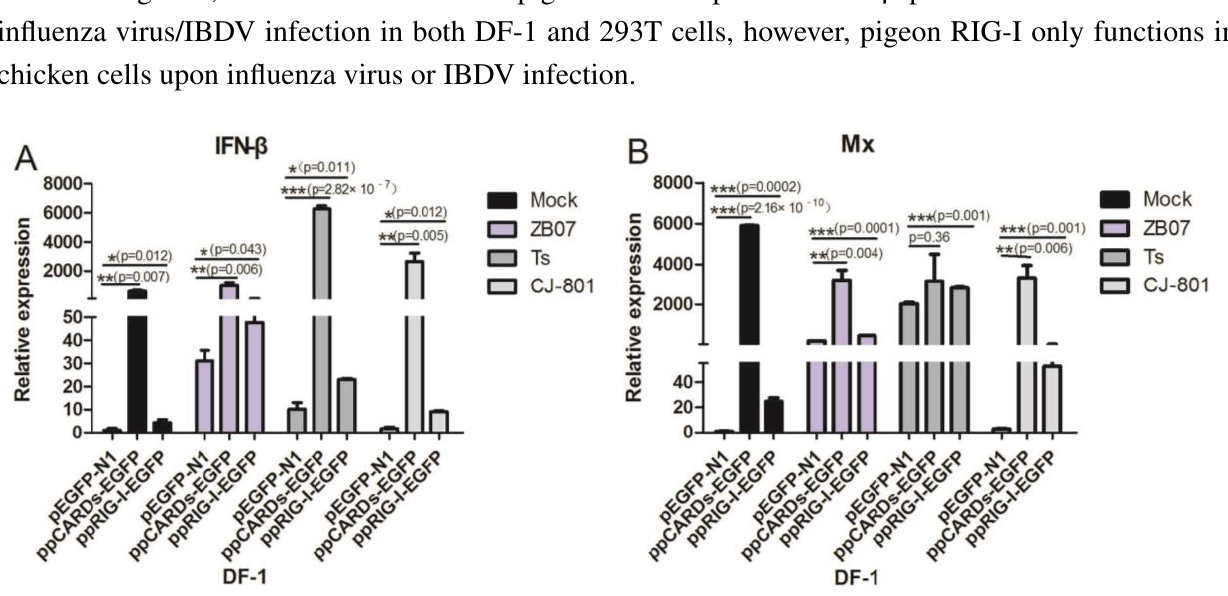
Figure 5. Figure 5. Cont.